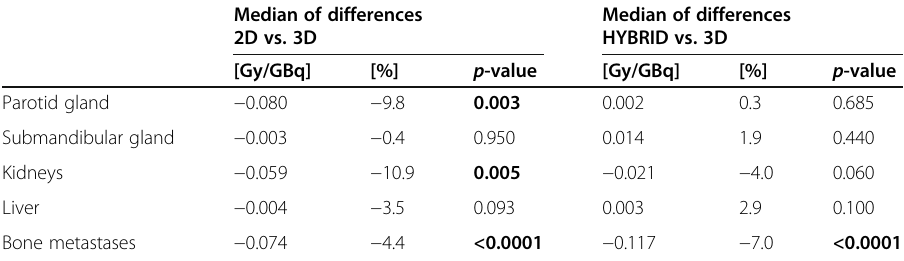
Table 3 Median differences of estimated absorbed dose in normal tissues and bone metastases between 2D and 3D method, and between hybrid and 3D method Median of differences 2D vs.